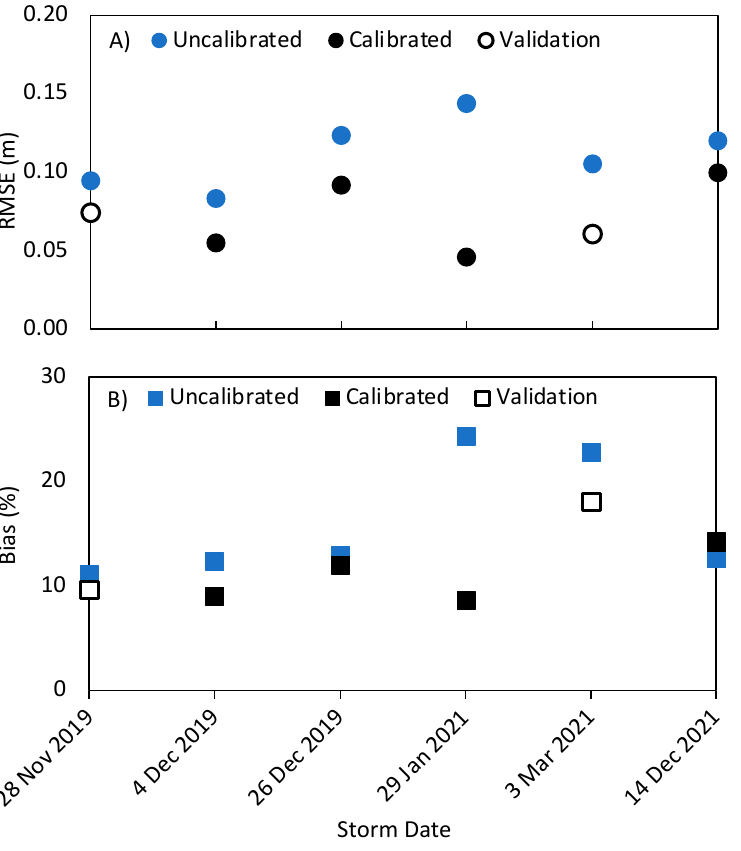
Figure 3. ( A ) Root mean squared error (RMSE) and ( B ) percent bias (Bias) for uncalibrated, calibrated, and validated model results for simulated water depth.